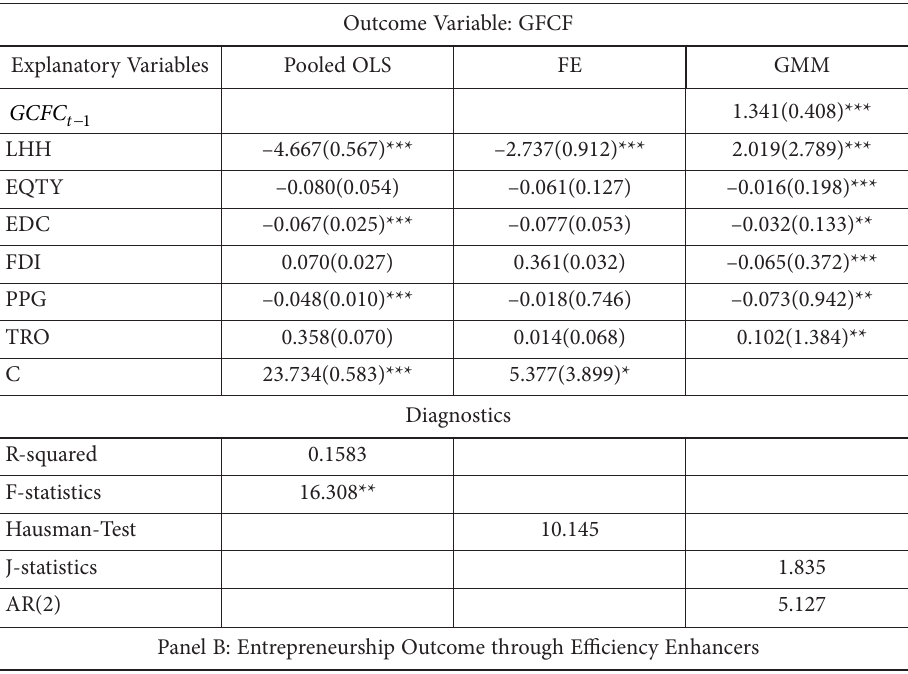
Table 5. Entrepreneurship Channels and Entrepreneurship Outcomes ( Verification Estimates ) (source: Authors’ computation) Panel A: Entrepreneurship Outcome through Basic